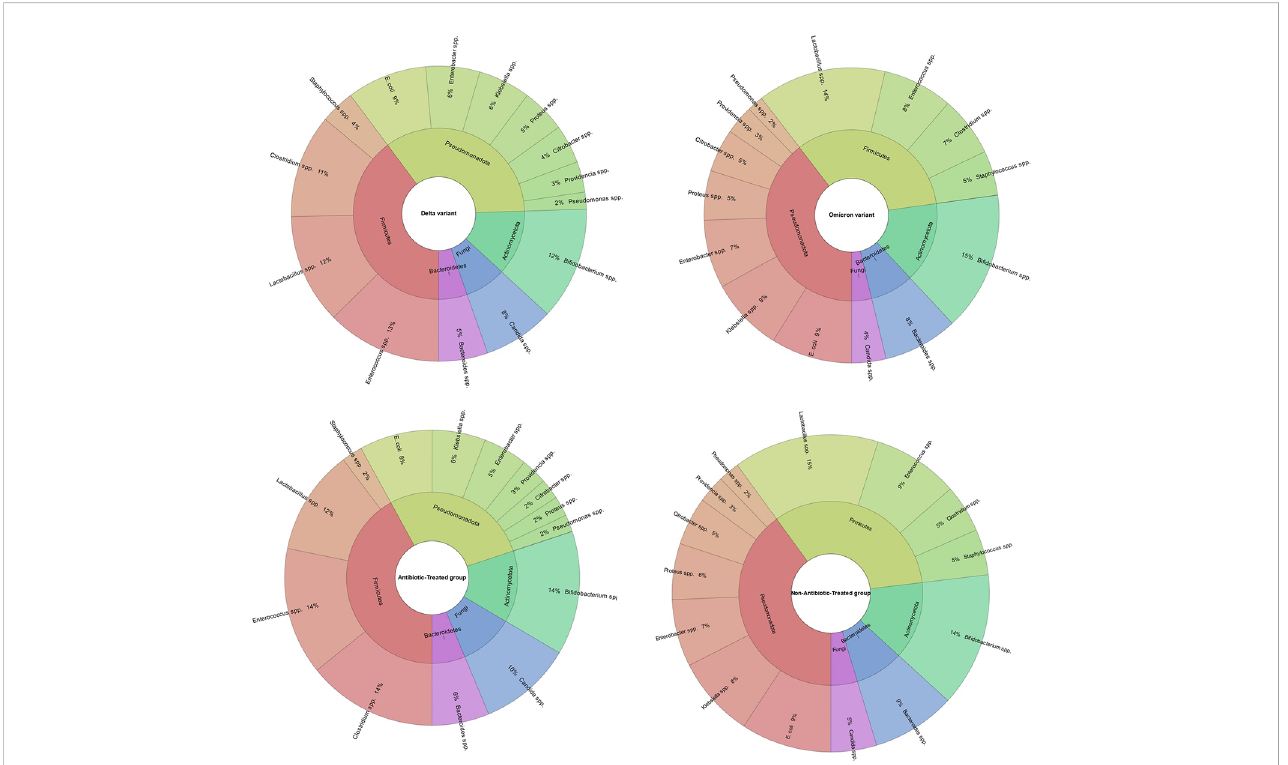
FIGURE 5 Comparison of gut microbiota composition in patients infected with Omicron or Delta variants of SARS-CoV-2 and Antibiotic-Treated or Non-Antibiotic- Treated group. The results indicate that the Omicron group had a signi fi cantly higher abundance of the genera Bi fi dobacterium, Bacteroides, Klebsiella, Enterobacter , and Lactobacillus compared to the Delta group (P<0.05). In contrast, the Delta group had a signi fi cantly higher abundance of the genera Clostridium, Enterococcus, and Candida compared to the Omicron group (P<0.05). The fi gure also shows the comparison of gut microbiome composition between patients treated with antibiotics and those who were not. It demonstrates that patients treated with antibiotics had a higher abundance of the genera Enterococcus, Candida , and Clostridium , while non-antibiotic-treated group had a higher abundance of the genera Proteus, Klebsiella, Citrobacter, Staphylococcus, Lactobacillus and Bacteroides